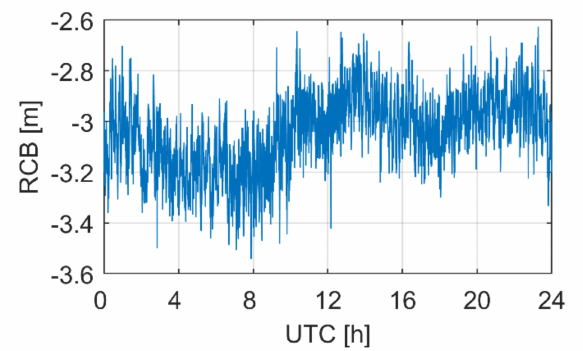
Figure 2. Time series of the Galileo RCB calculated using the IGG1–IGG2 baseline data collected on DOY 268,